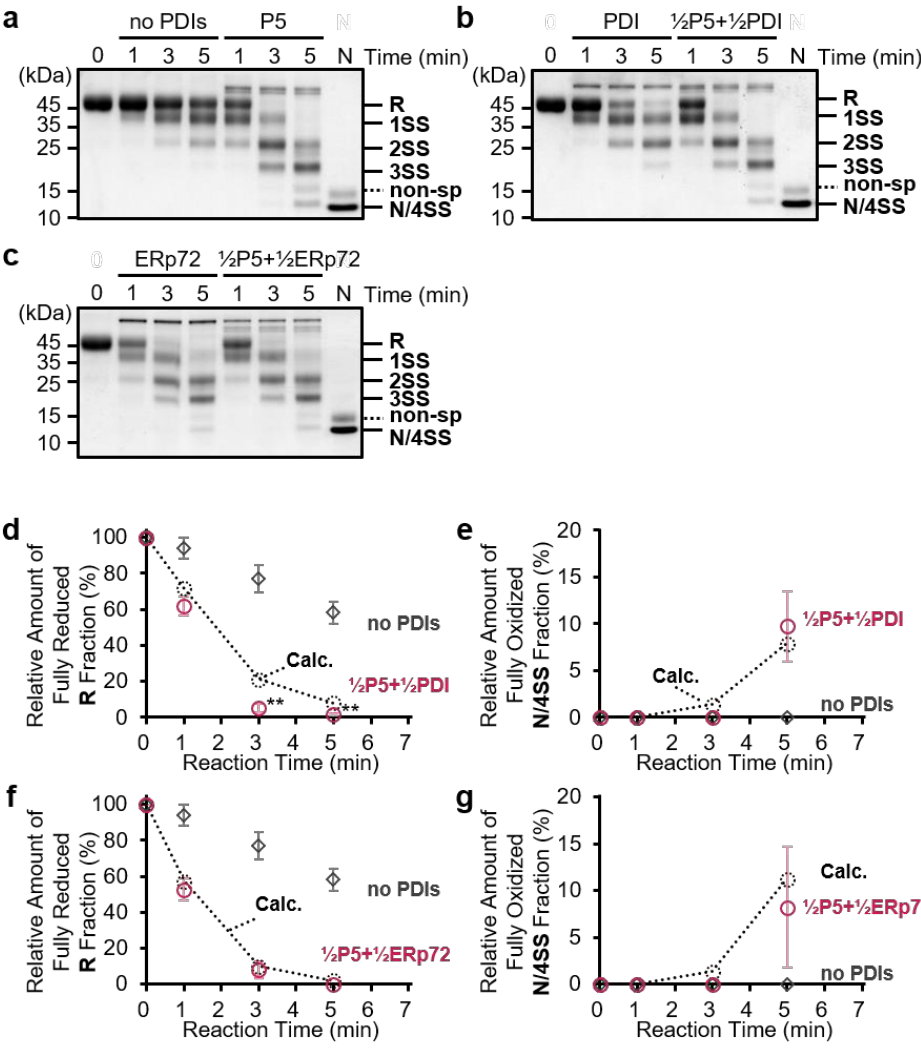
Figure 2. Disulfide bond formation in RNase A catalyzed by P5 in concert with PDI/ERp72. ( a – c ) RNase A oxidation assay in the presence of P5, PDI, ERp72, P5/PDI, and P5/ERp72. Reduced and denatured RNase A (16 µM) was incubated without PDIs or with 1 µM P5 ( a ); 1 µM PDI or 0.5 µM P5 and 0.5 µM PDI ( b ); or 1 µM ERp72 or 0.5 µM P5 and 0.5 µM ERp72 ( c ). In addition to reduced RNase A, an equal amount of native RNase A was loaded into lane N as a positive control. R , fully reduced form of RNase A; 1SS , 2SS , 3SS , intermediates with one, two, or three disulfide bonds, respectively; N/4SS , mixture of the native form of RNase A and the fully oxidized form possessing four disulfide bonds; non-sp , non-specifically modified band. ( d – g ) Quantification of the relative band intensities of the fully reduced form ( R : d , f ) and fully oxidized form ( N/4SS : e , g ) following SDS-PAGE analysis ( a – c ). Error bars indicate the means ± SEM of three independent experiments. ½P5+½PDI : results for 0.5 µM P5 and 0.5 µM PDI; ½P5+½ERp72, results for 0.5 µM P5 and 0.5 µM ERp72; no PDIs , results without PDIs; Calc. , calculated arithmetic means of the results of P5 alone and PDIs alone (see Figure S1). ** p < 0.01, statistical significance between the means of ½P5+½PDIs and Calc. using a two-tailed t-test.